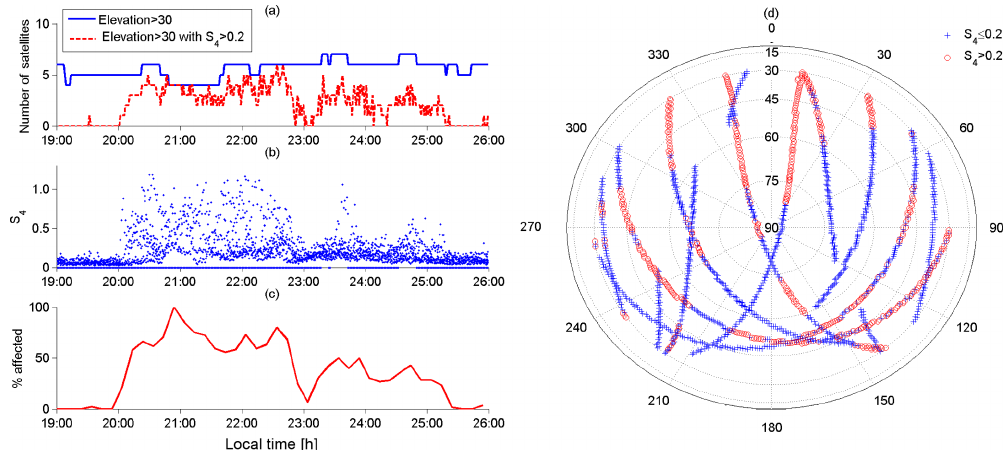
Figure 2. Example from 21 November 2014. (a) Total number of satellites visible for elevation > 30 ◦ and the number of satellites affected by scintillation with S 4 > 0 . 2. (b) All the S 4 occurrences detected for all satellites from (a) . (c) Average 10min percentage of satellites visible for elevation > 30 ◦ affected by scintillation with S 4 > 0 . 2. (d) Sky plot for the night showing the satellite passages; the red dots represent the cases with S 4 > 0 . 2.